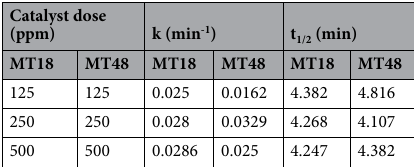
Table 3. Kinetic data of photodegradation of oil spills using prepared MOFs under different conditions.